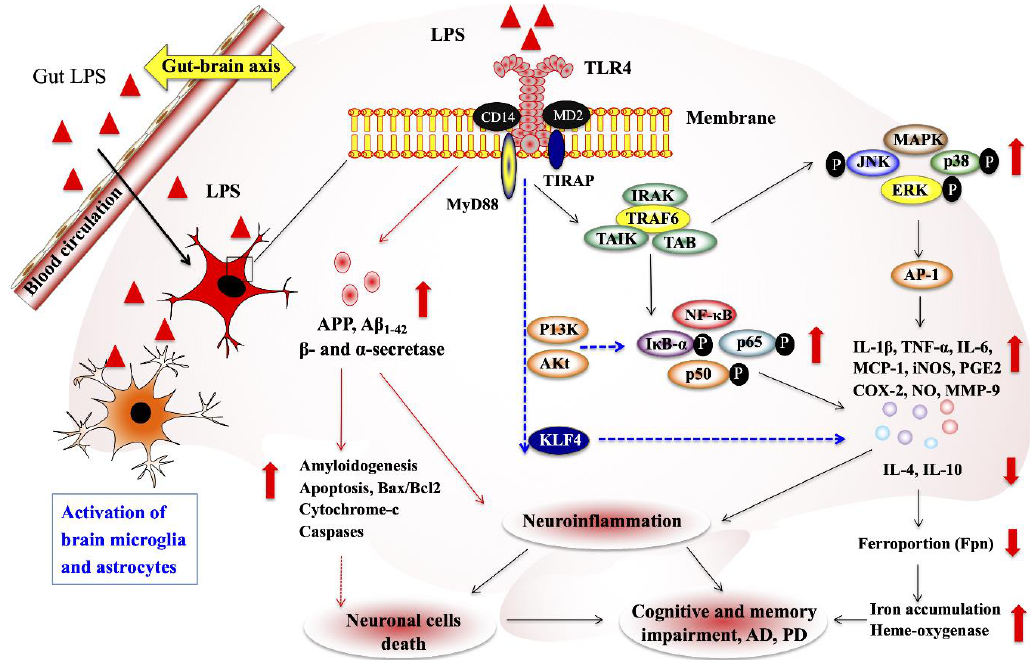
Figure 3. Gut–brain axis exacerbates neurological disorders through gut-microbiota-derived molecular patterns. The dysregulated LPS productions were able to translocate to the brain through the circulation, where it mediates various dangerous signaling by interacting Toll-like receptor 4 (TLR4), resulting in the induction of neuroinflammation and other neurological diseases. Lipopolysaccharide (LPS), Krüppel-like factor 4 (KLF4), nitric oxide (NO), prostaglandin E2 (PE2), matrix metalloproteinase-9 (MMP-9), and amyloid precursor protein (APP). ( ↑ ↓ indicate up and down-regulation)